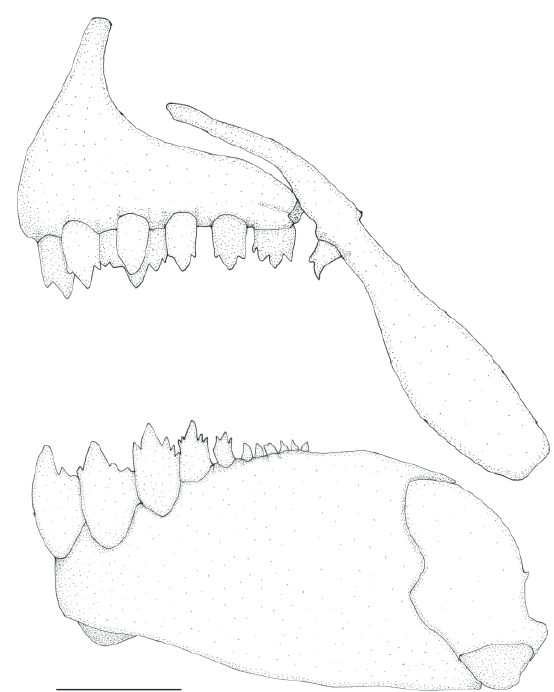
Fig. 4. Hyphessobrycon langeanii , paratype, MZUSP 73313. Upper and lower jaws, lateral view, left side. Scale bar 1mm. Table 1. Morphometric data for Hyphessobrycon langeanii . Measurements based on the holotype (MZUSP 75127)